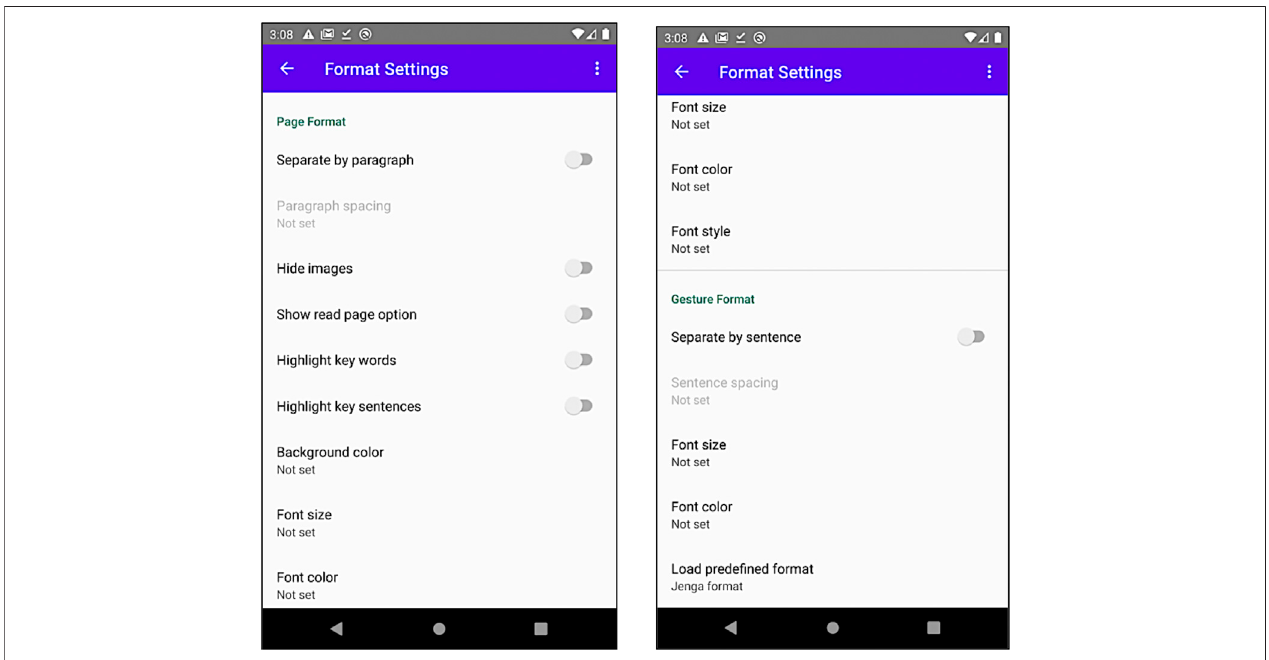
FIGURE 11 | Settings for content